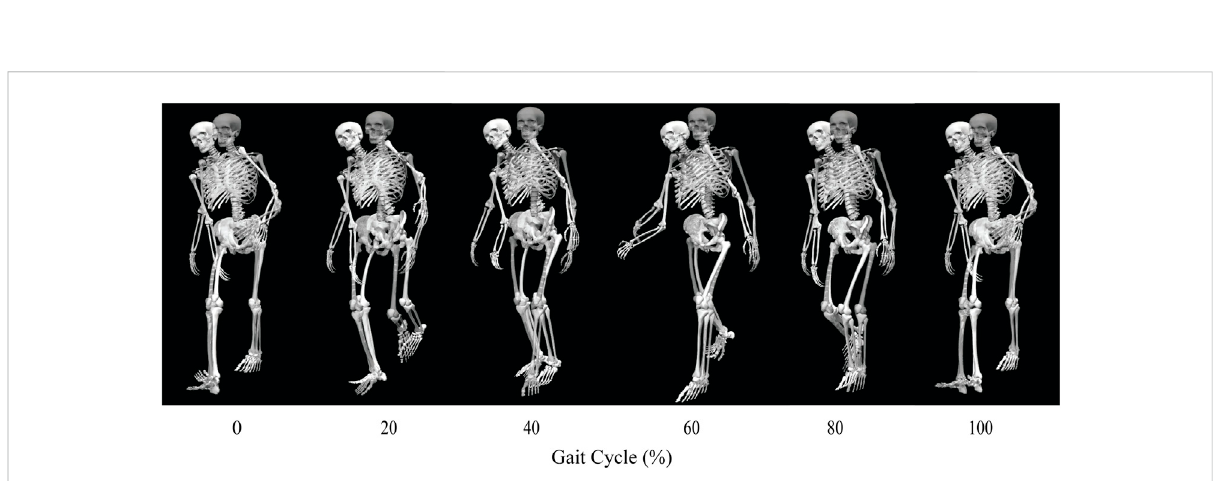
FIGURE 4 Animation strip comparing the subject ’ s experimental walking motion (translucent skeleton) to his predicted walking motion when post- surgery operated side psoas strength was 150% of its pre-surgery value (opaque skeleton).